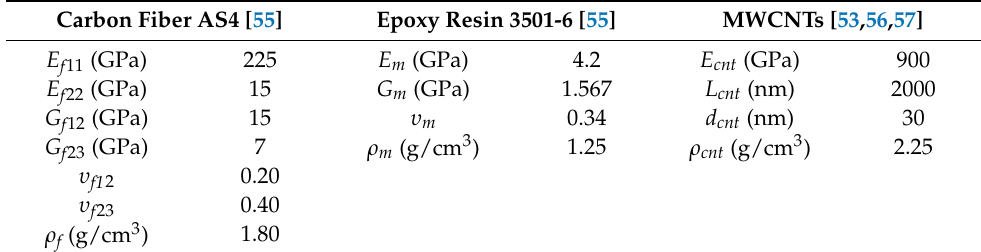
Table 1. Materials properties of the components.